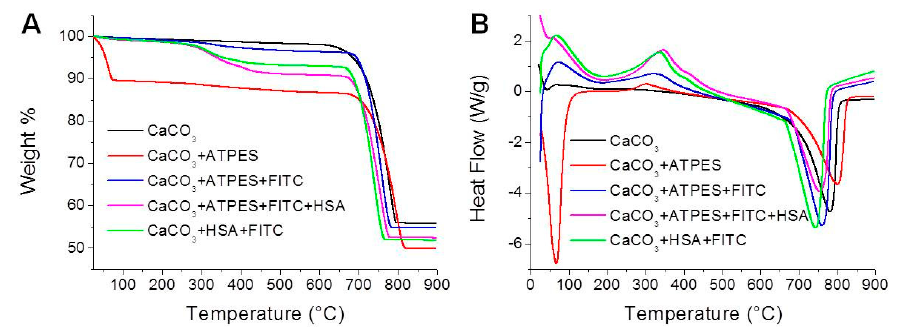
Figure 2. Thermogravimetric Analyses ( A ) and Differential Scanning Calorimetry ( B ) characterization of the synthesized nanoparticles.